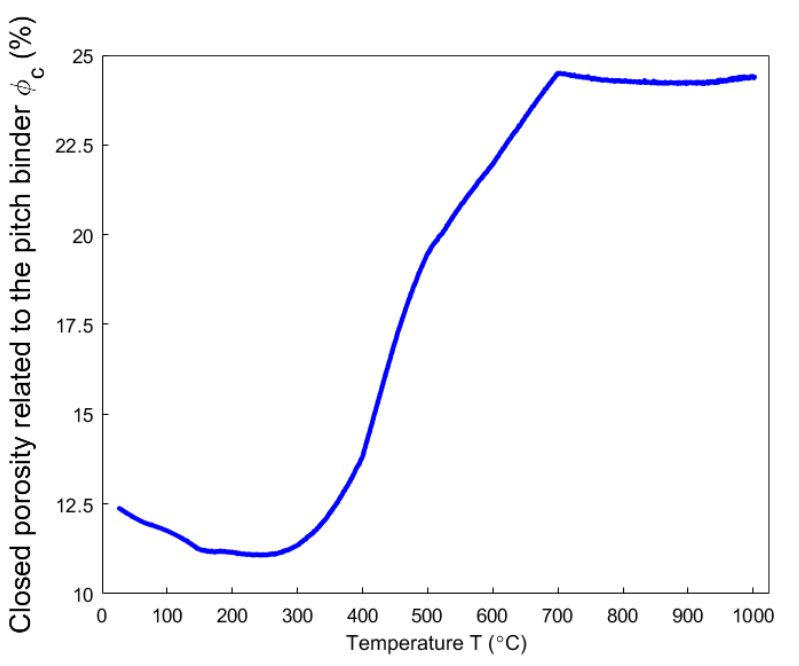
Materials 2021 , 14 , 923 Figure 16. Sum of intergranular, interfacial and bubble closed porosities related to the pitch binder.